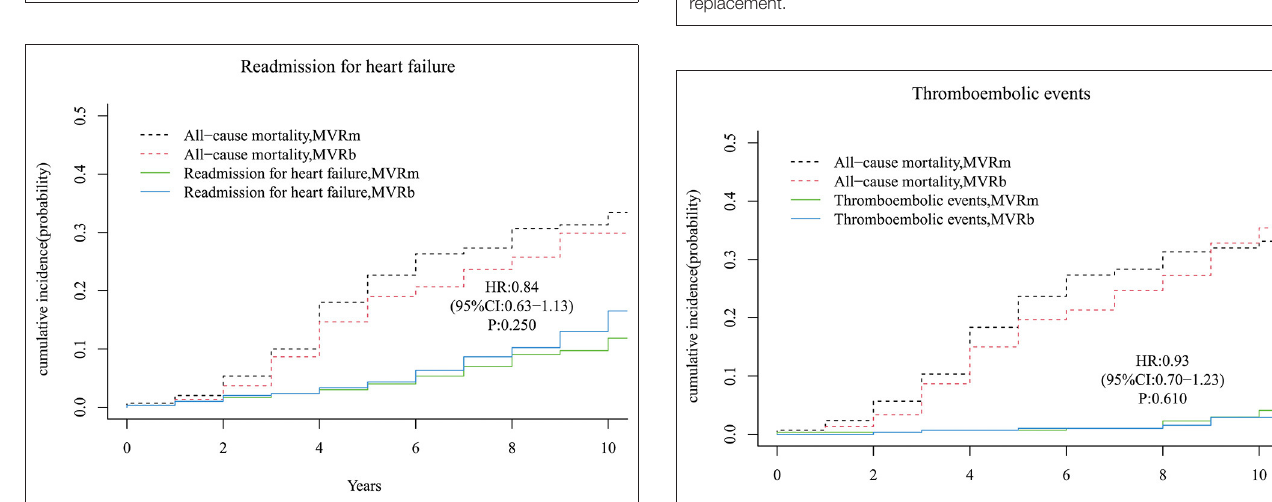
FIGURE 6 | Cumulative incidence of readmission for heart failure. MVRm, mechanical mitral valve replacement; MVRb, bioprosthetic mitral valve replacement.